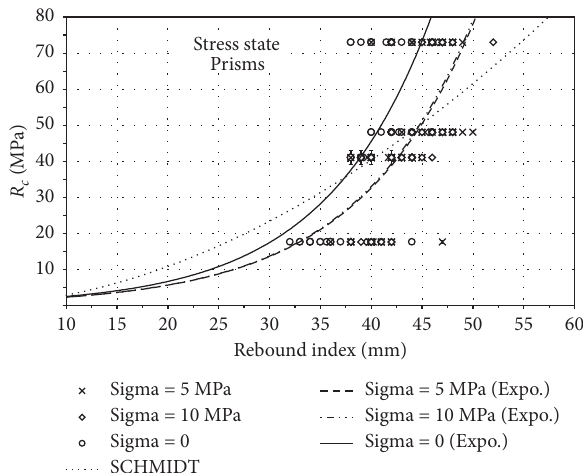
Figure 7: Calibration curve for different stress states. Average compressive stress: dashed line: 5MPa; dash-dotted line: 10MPa; continuous line: 0MPa; dotted bold: Schmidt curve. Calibration curve: R c � e a RI ; RI � rebound index; a ∈ [0.088, 0.096]; R 2 � 0.67. Inside any dataset, C.o.V. ≤ 9% for vanishing stress; C.o.V. ≤ 6% for compressed prisms (5 and 10 MPa).